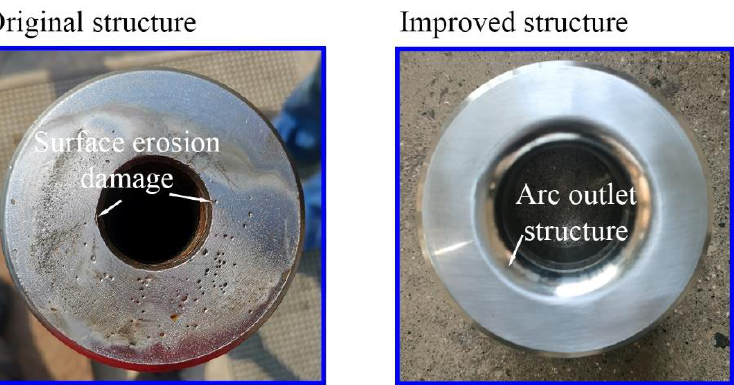
Figure 17. Photographs showing the outlet of the ball seat of the original and improved differential motion assemblies after the experiments.